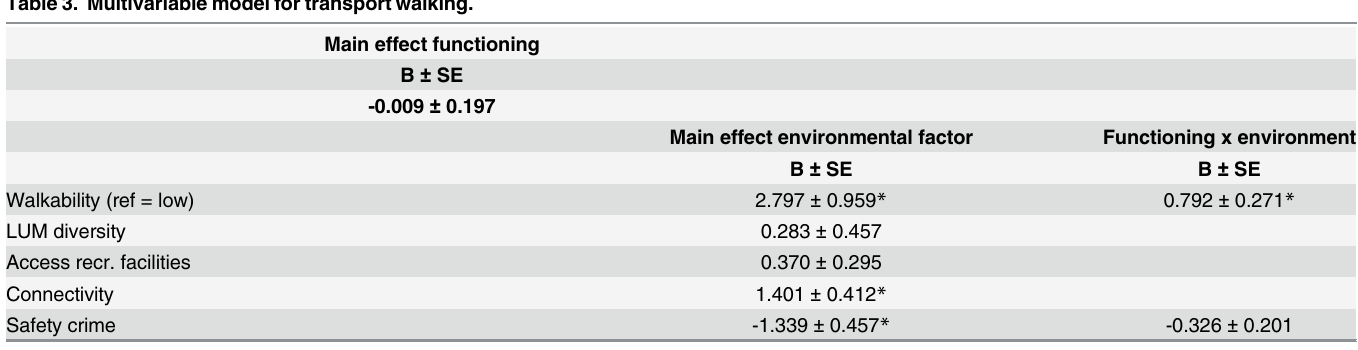
Table 3. Multivariable model for transport walking.